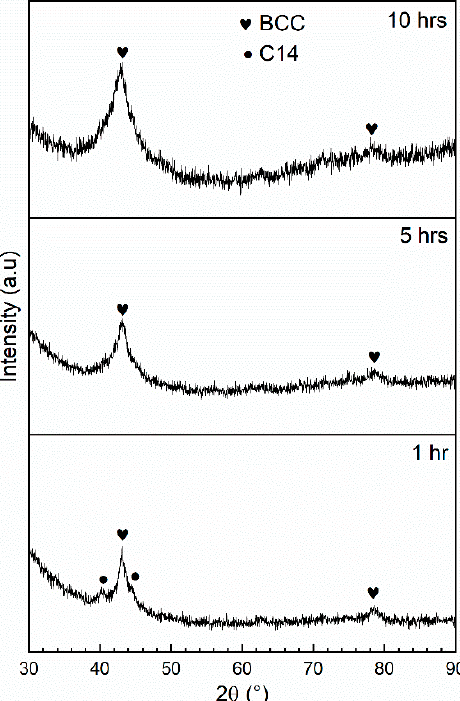
Figure 8. X-ray diffraction patterns of as-cast Ti 0.3 V 0.3 Mn 0.2 Fe 0.1 Ni 0.1 alloy before and after milling for